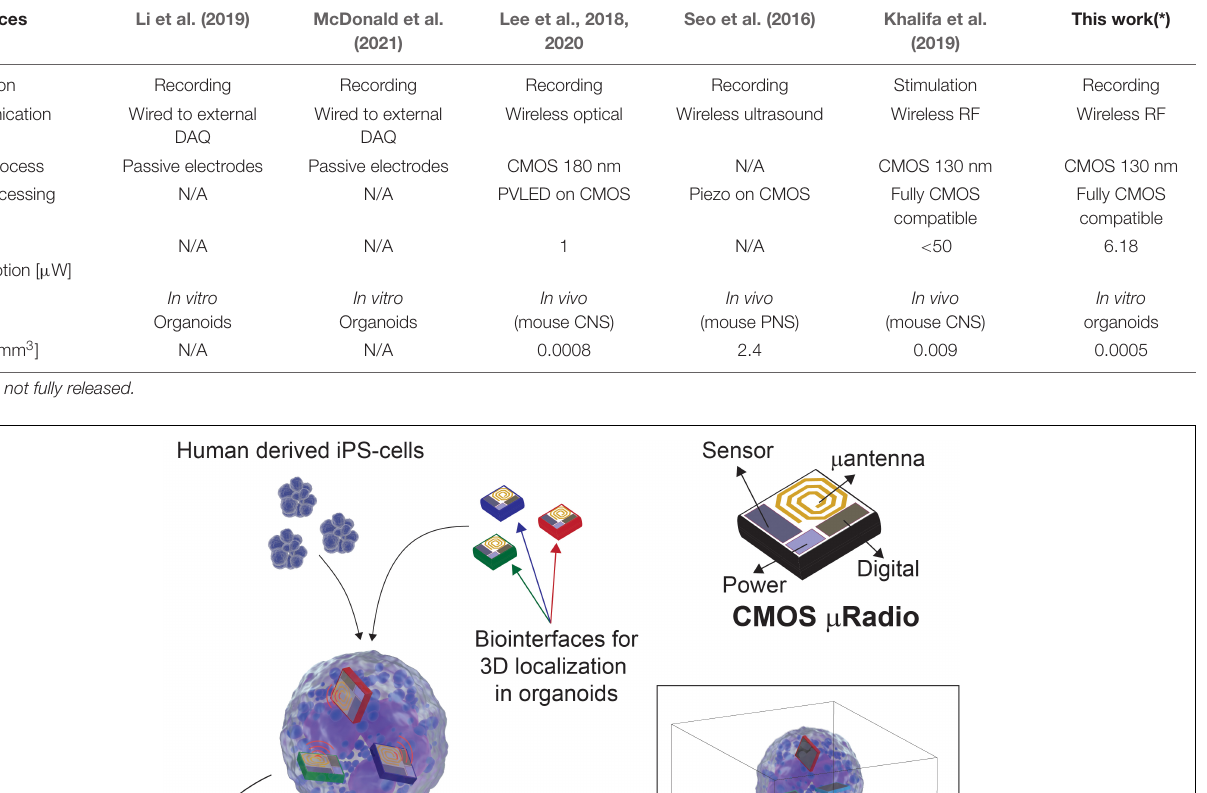
TABLE 1 | Performance Specifications of our solution in comparison to other State-of-the-Art Systems.